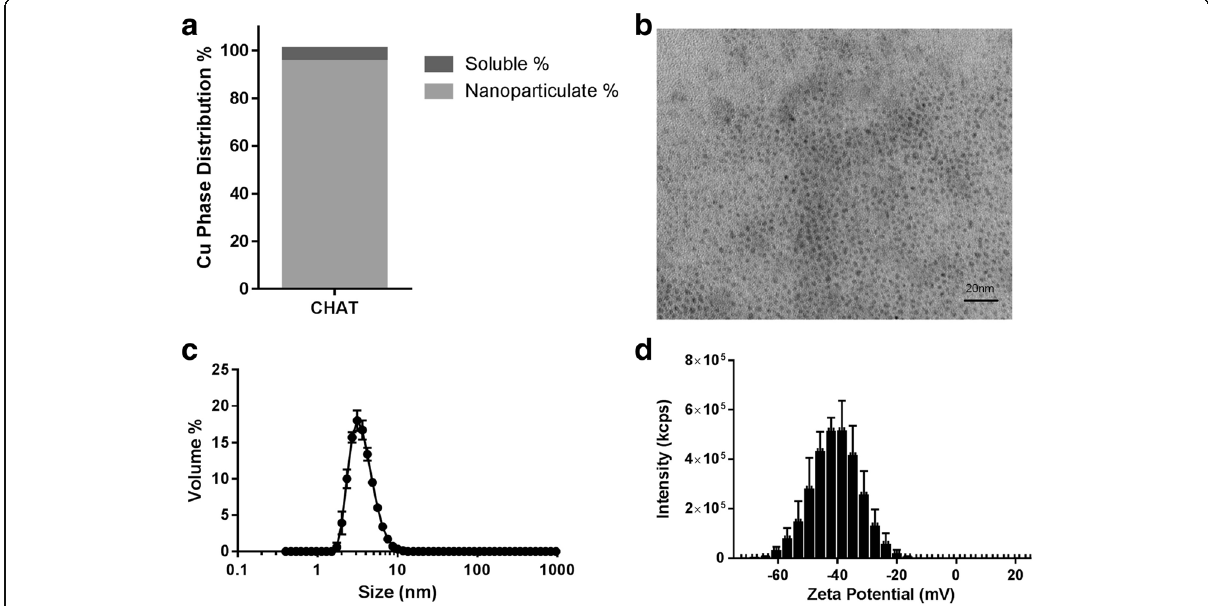
Fig. 1 Characterisation of CHAT stock solution. a Copper phase distribution at 2.5 g/L CHAT: soluble (< 3 KDa) and nanoparticulate percentage. b Nanoparticle dispersion imaging by TEM. c Hydrodynamic particle size distribution of freshly prepared particles, as determined by dynamic light scattering. d Zeta potential distribution ( n = 3; error bars represent standard